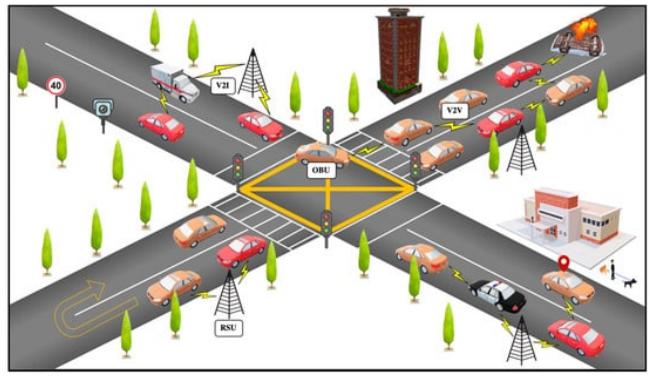
Figure 1. VANETs Communication.